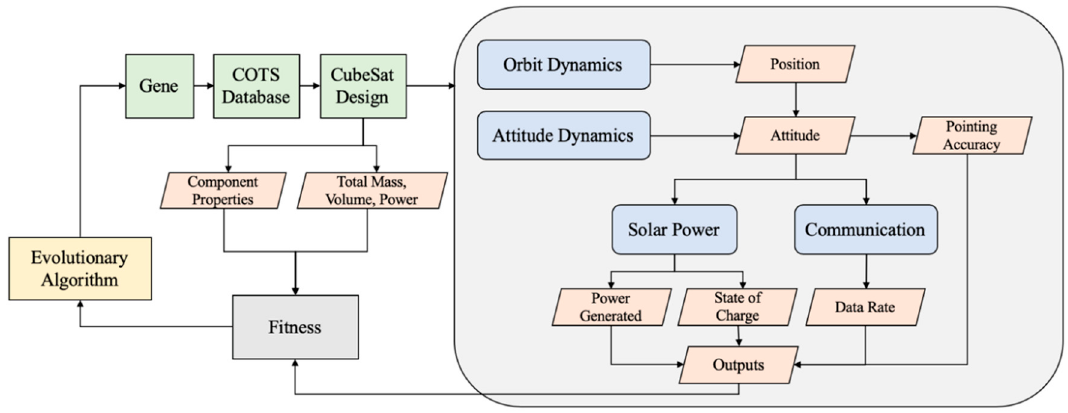
Figure 5. Simulation environment for CubeSat design optimization.